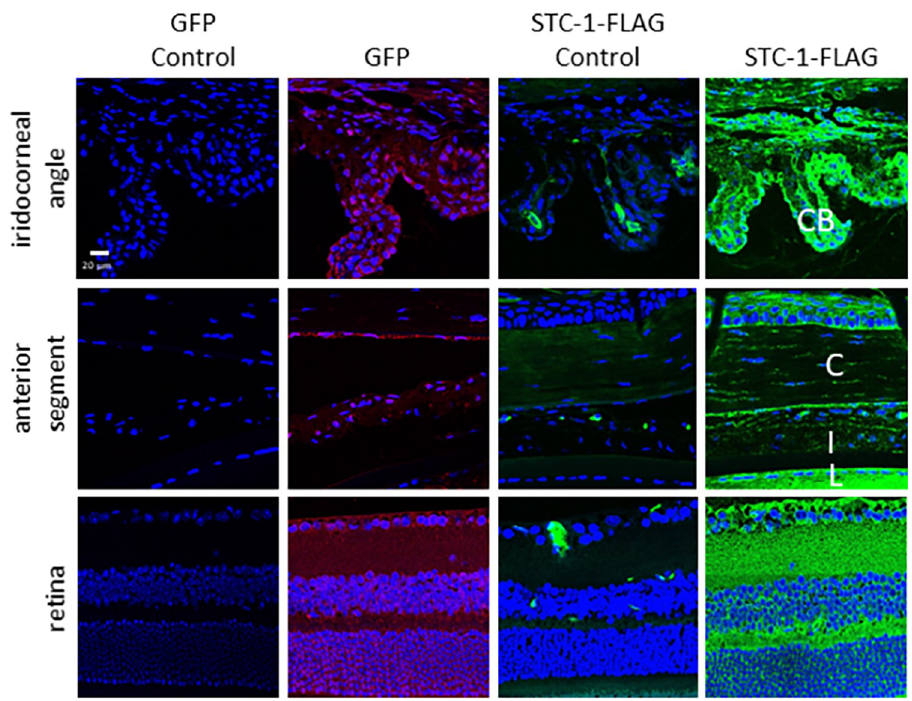
Fig 5. ssAAV2-STC-1 is expressed in a sustained fashion after intracameral injection. ssAAV2-STC-1-FLAG (3x10 9 VGs) was injected in one eye and ssAAV2-GFP (3x10 9 VGs) was injected into the fellow eye (n = 22) of 3-month-old C57BL/6J mice. At 8 weeks post-injection, diffuse intraocular STC-1-FLAG expression was seen in the iridocorneal angle including ciliary body (CB); the anterior segment including cornea (C), iris (I), and lens capsule (L); and retina. Note mild autofluorescence in STC-1-FLAG